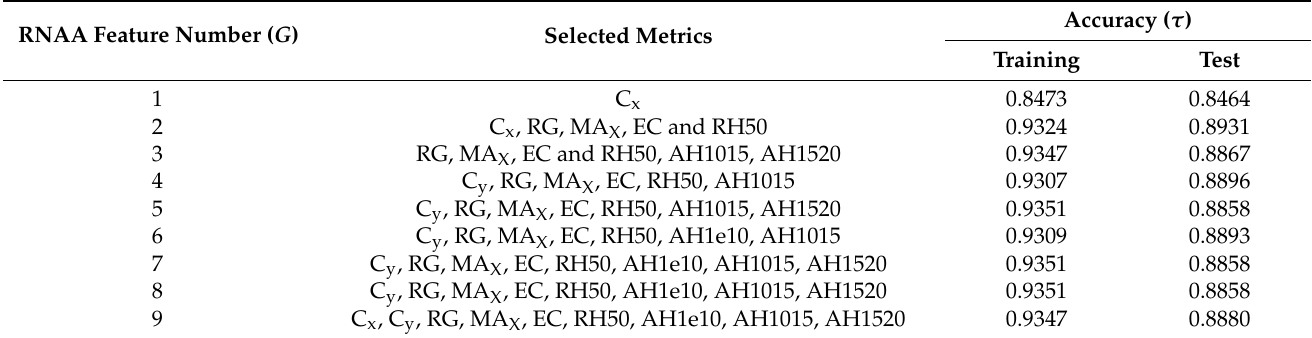
Table 3. Key metrics selected from the nine LVIS metrics for age-attribute learning. RNAA Feature Number ( G